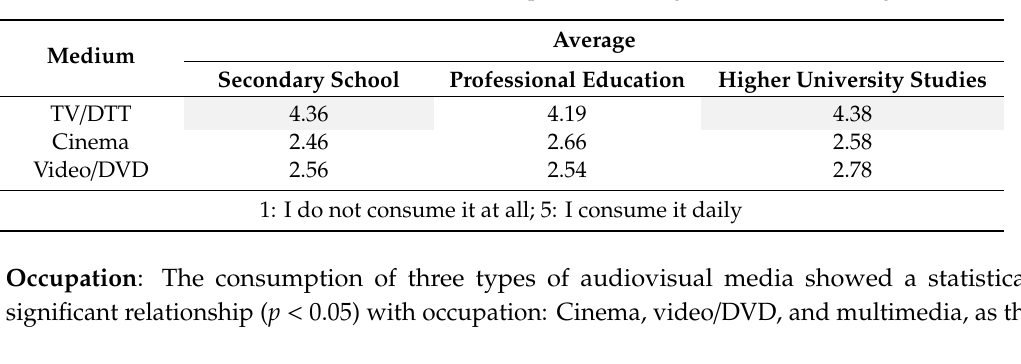
Table 6. Table 6. Cinema, TV, and video / DVD consumption according to education